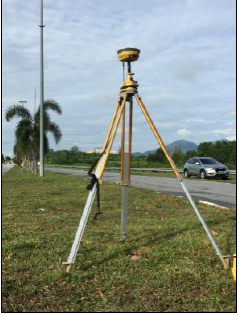
Figure 10. Topcon Hiper V GNSS receiver is used to obtain the coordinate value of observation stations